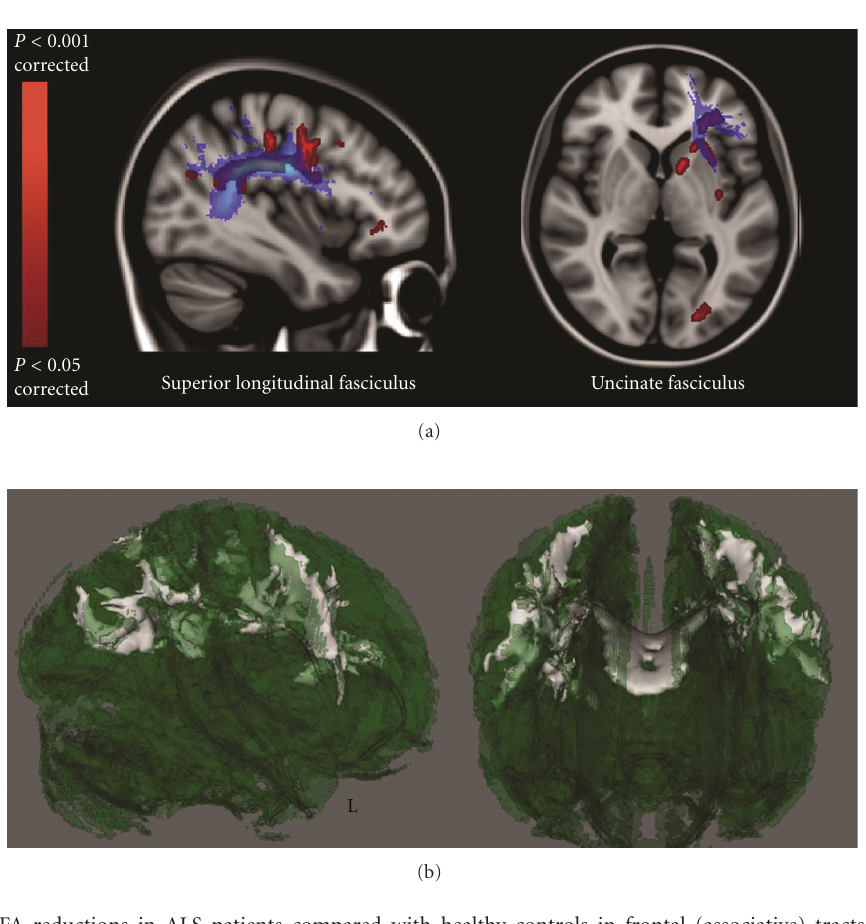
Figure 2: Regional FA reductions in ALS patients compared with healthy controls in frontal (associative) tracts (TBSS DTI analysis performed by Cirillo et al. [24]). In (a), blue shows the superior longitudinal and the uncinate fasciculi (derived from the Johns Hopkins University White-Matter Tractography atlas [106, 107]), whilst red shows significant FA decrease in ALS patients ( P < 0 . 05, corrected). (b) illustrates 3D renderings of the FA skeleton (green), where white shows regional FA reductions in patients. Remarkably, these di ff usivity changes resemble those which have been described in patients with the behavioral variant of frontotemporal